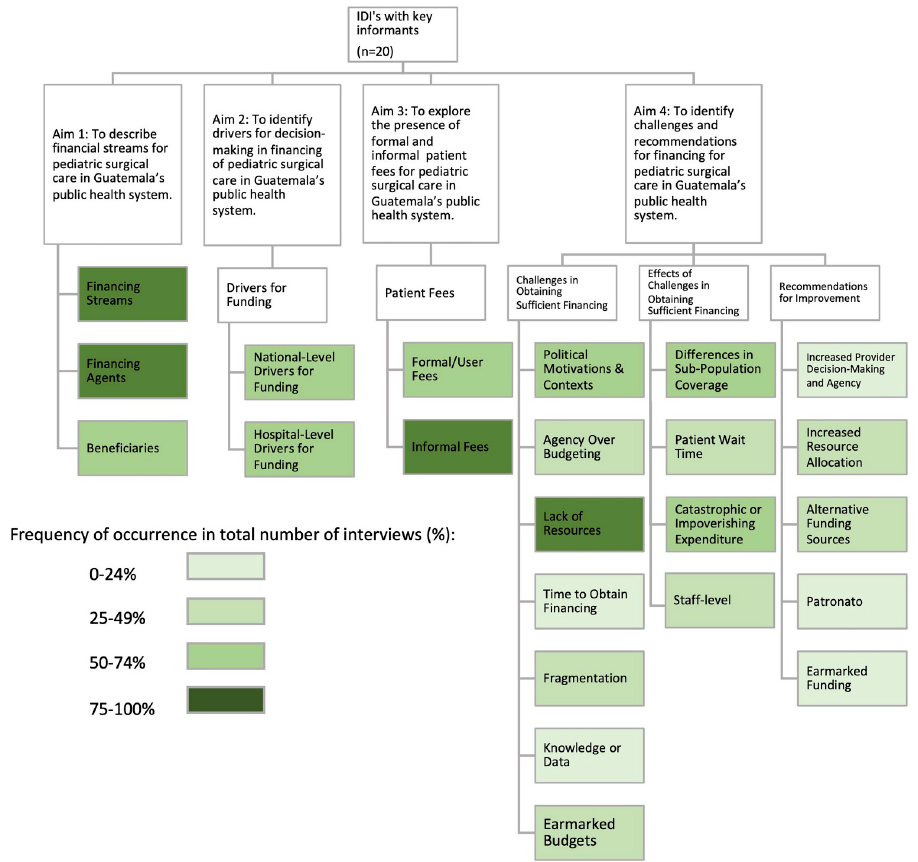
Fig 3. Dominant themes for pediatric surgical financing in